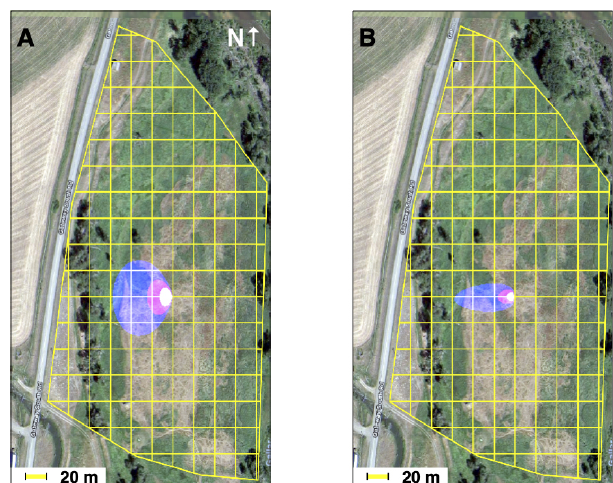
Figure 3. An eddy covariance flux footprint calculated follow- ing (a) Hsieh et al. (2000) extrapolated to two dimensions follow- ing Detto and Katul (2006) and (b) Kljun et al. (2015) for a single 30min interval superimposed on the study field (Fig. 1). The purple, pink and white areas represent the 95%, 75% and 50% footprint at 10:30–11:00 mountain standard time on 8 January 2018. The frac- tion of the footprint in each grid box is summed for each 20m pixel to calculate the contribution of each pixel to the total flux. Back- ground image: © Google, Maxar Technologies and the USDA Farm Service Agency